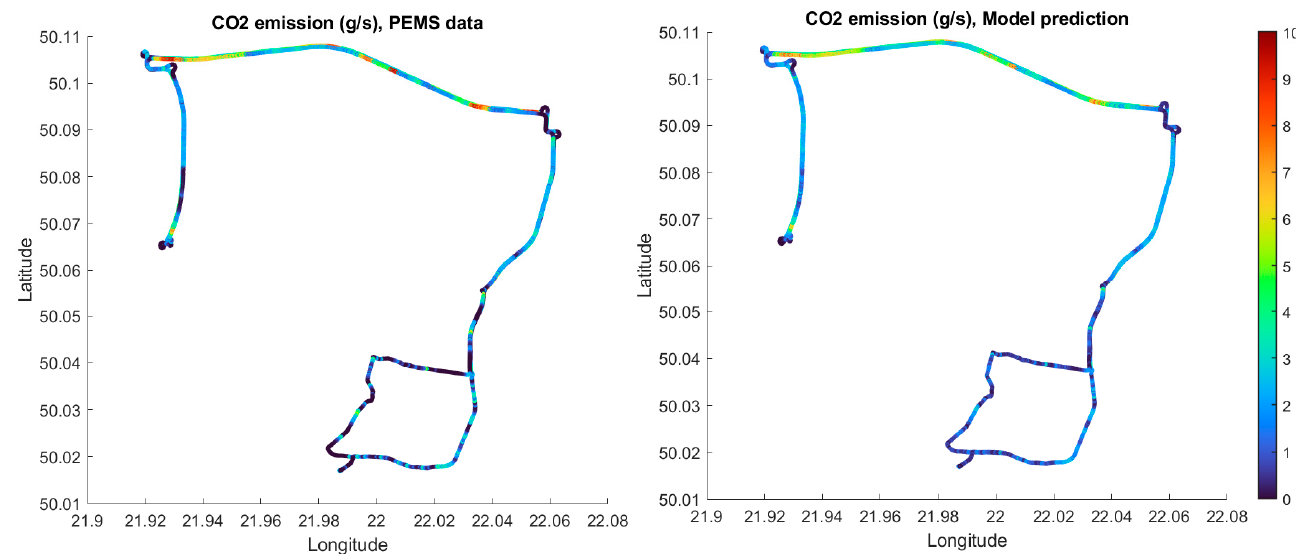
Figure 9. Comparison of emission map for the real data (PEMS) and the model prediction data for CO 2 emission.